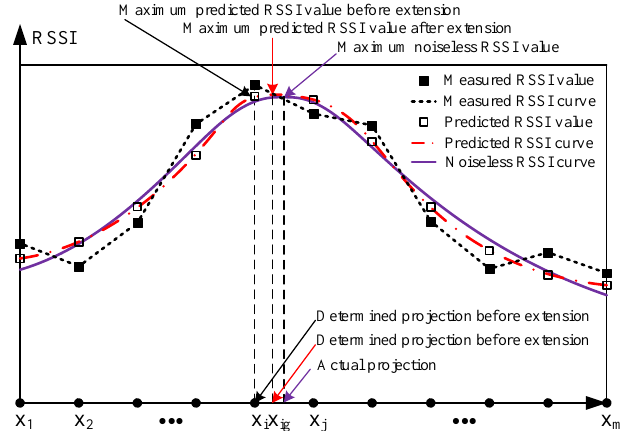
Figure 4. Determining the projection of a node on the trajectory by the SVR-based interpolation